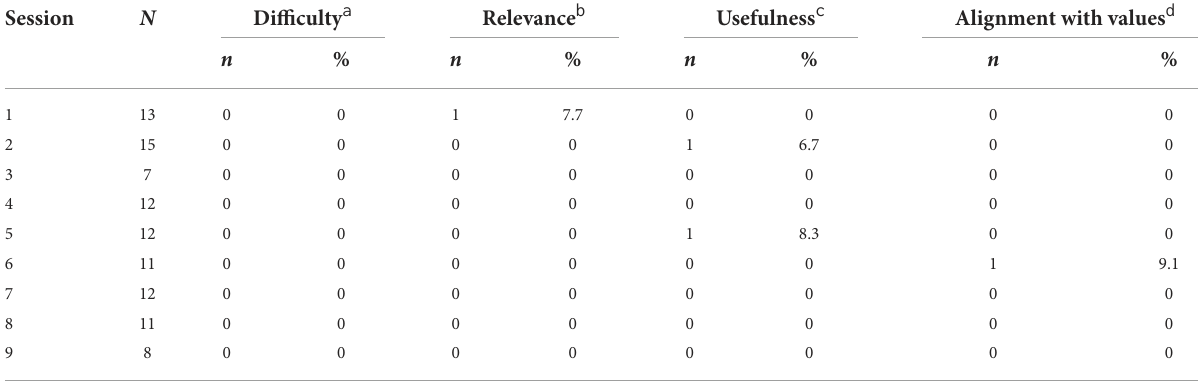
TABLE 5 Caregivers’ rated acceptability of contents of the sessions.